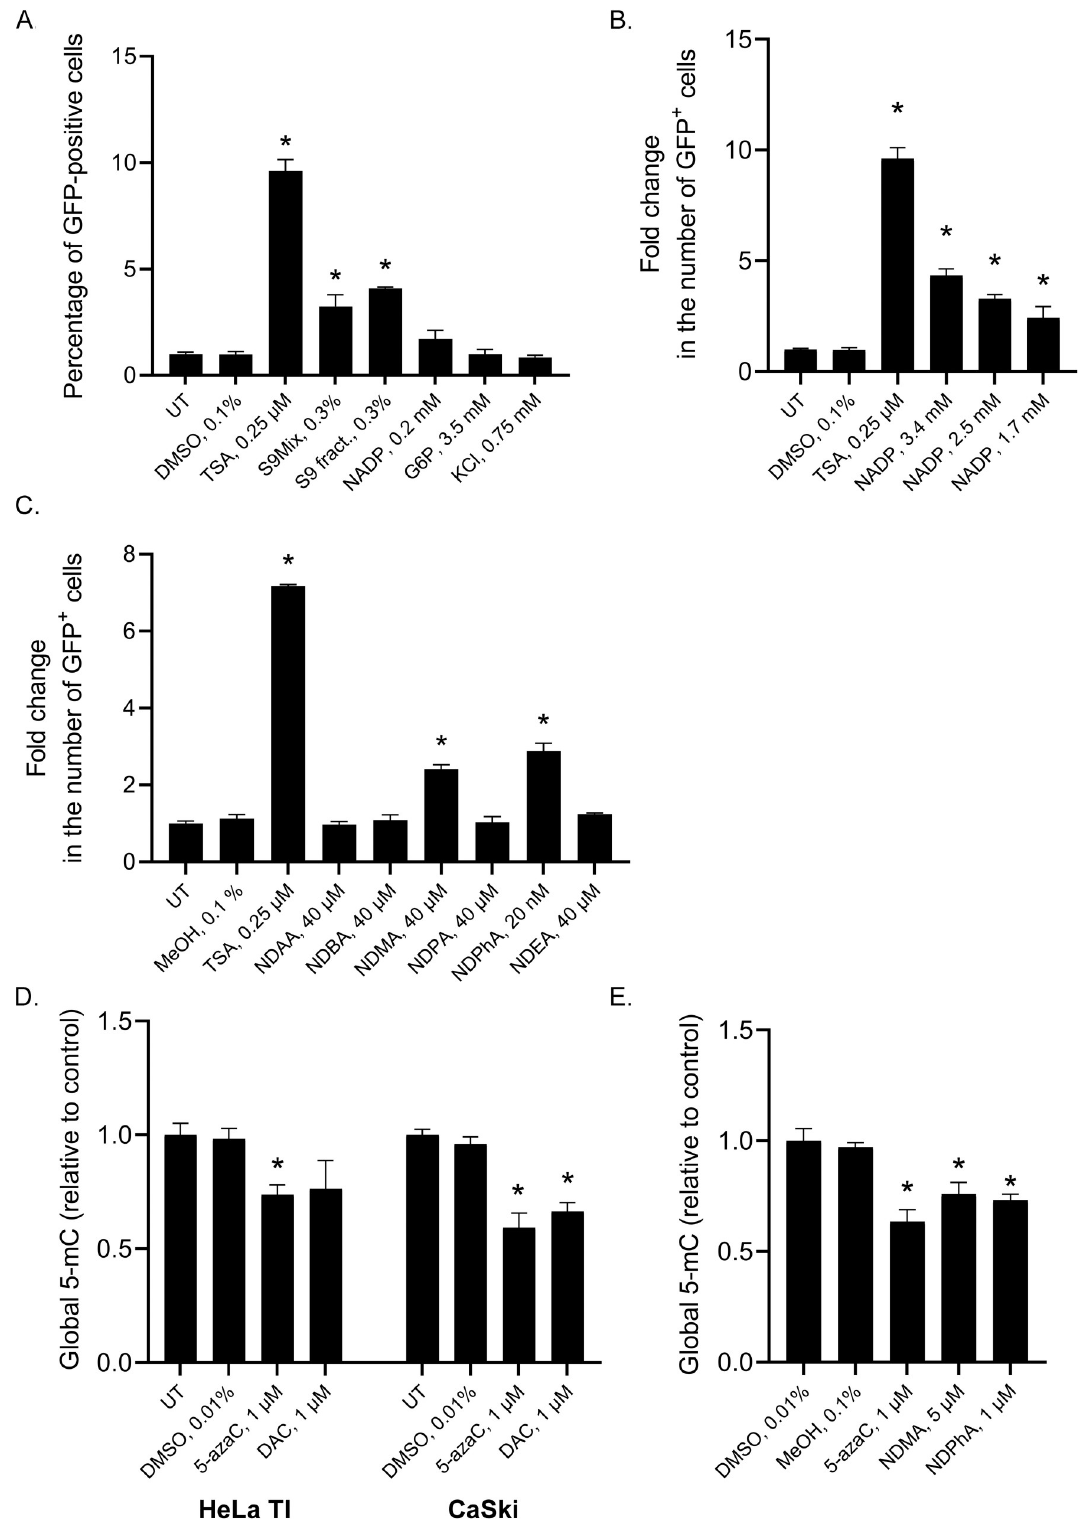
Fig 6. A, B. Effects of the S9 mixture and its components on GFP reactivation in HeLa TI cells. C. Effects of procarcinogens from the N-nitrosamine class on GFP reactivation in HeLa TI cells. GFP-positive cells were counted with flow cytometry. Data normalized